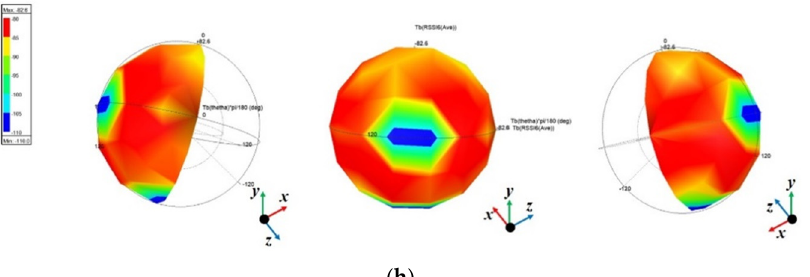
Figure 7. Antennas in the earbuds and RSSI tests using the head phantom: ( a ) plastic zorb ball mimicking a sensing sphere; ( b ) configuration of the measurement; ( c ) human phantom centered in the zorb ball as a TX in the form of a BLE module; ( d ) scheme to collect data from grid of sensors on the sphere; ( e ) device positioned on the SAM for the RSSI test; ( f ) measured points on the latitudes; ( g ) received signal strength distribution plot on the ball about the conventional antenna earbud; ( h ) received signal strength distribution plot on the ball about the proposed antenna earbud.